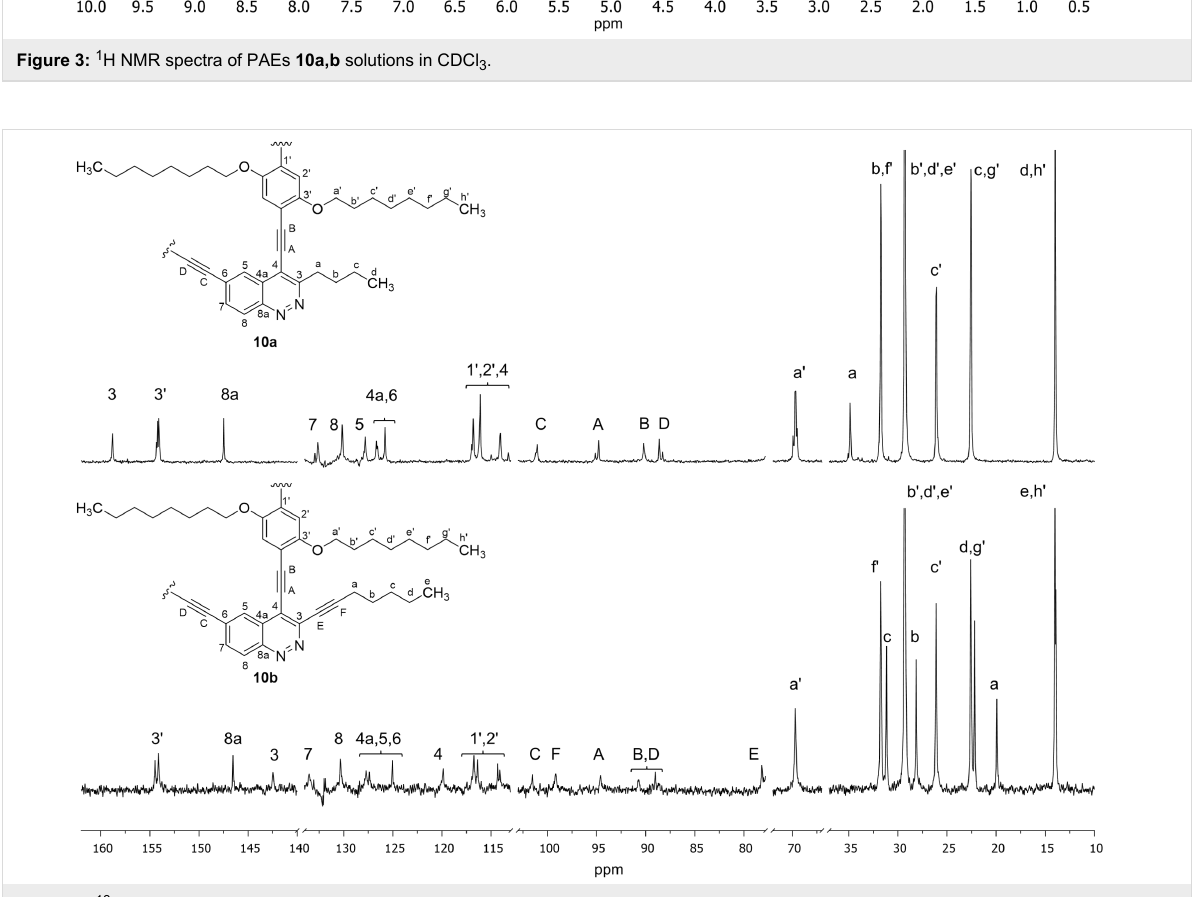
Figure 3: 1 H NMR spectra of PAEs 10a,b solutions in CDCl 3 .